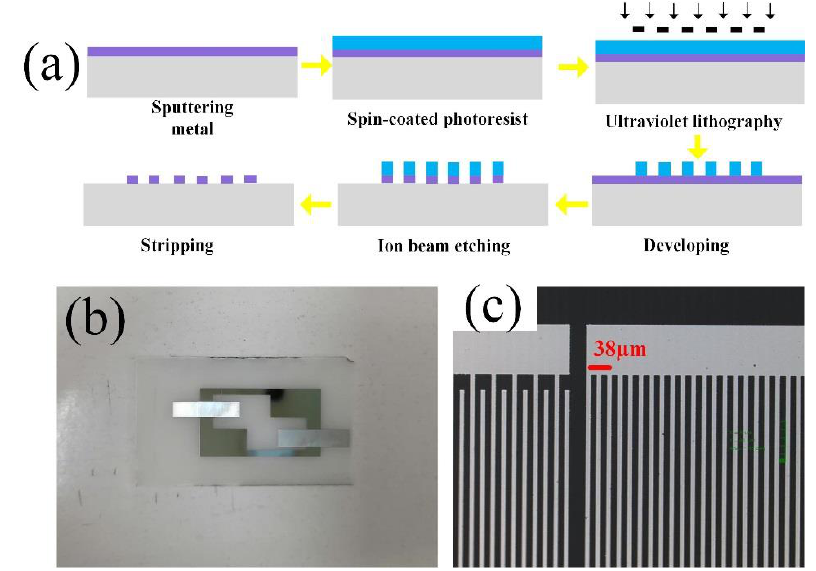
Figure 3. ( a ) The process of sensor preparation. ( b ) Optical image of the prepared sensor. ( c ) Confo- cal microscope image of the interdigital transducers structure. microscope image of the interdigital transducers